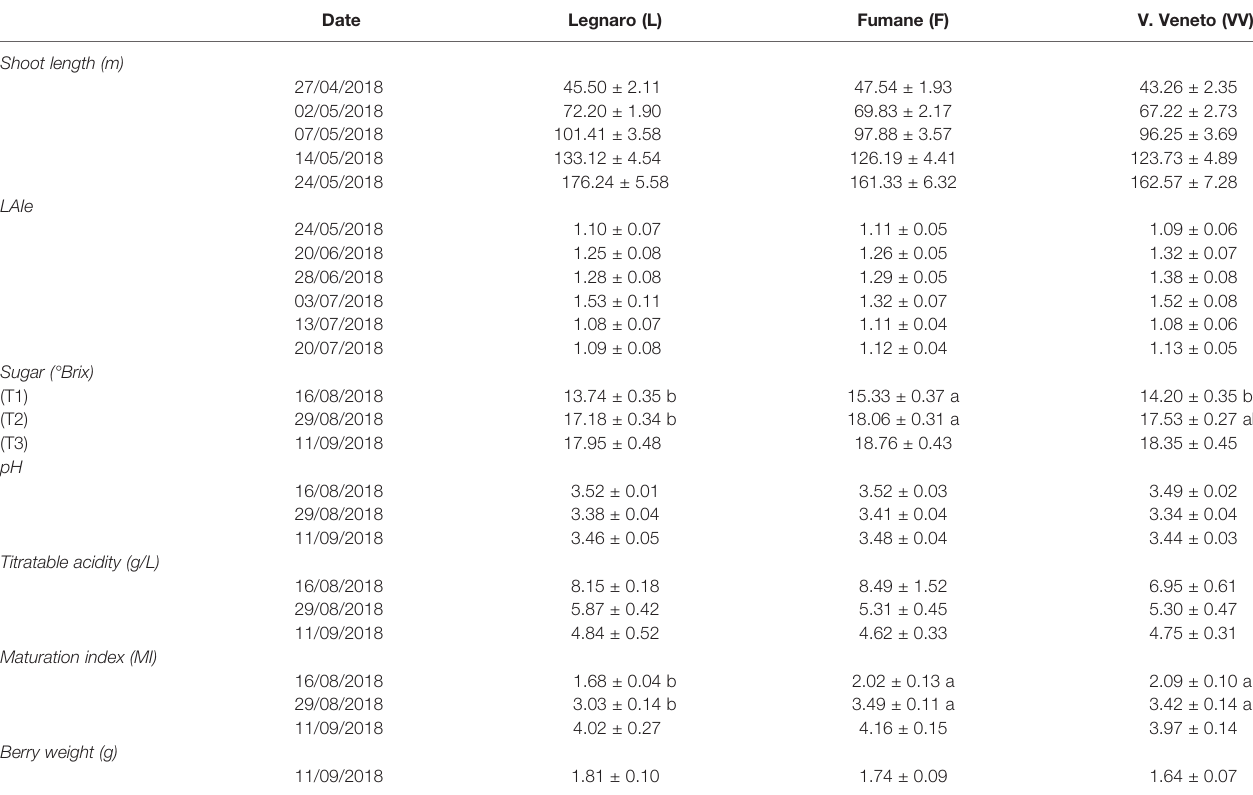
TABLE 2 | Canopy and berry physiological